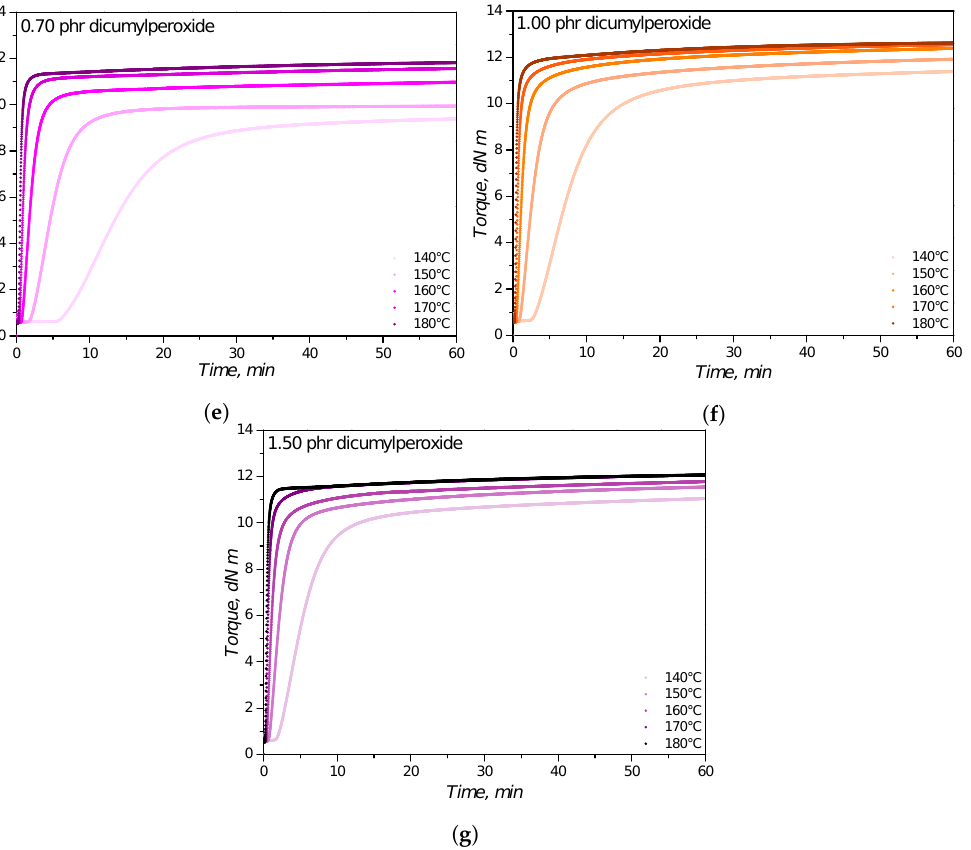
Figure 1. Rotational rheometry (RPA, 0.5° deformation at 1.667 Hz) curves for silicone rubber com- pounds with varied dicumylperoxide concentrations ( b – g ) at different crosslinking temperatures. The plot ( a ) (torque vs. time curve) is related to the pure solid silicone rubber without dicumylperoxide. For all dicumylperoxide concentrations, the temperature increase shortens the induc- tion or scorch time and lowers the minimum detected torque, as also depicted in Table